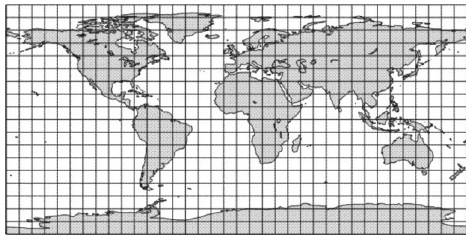
Fig. 25. Map of the World in Plate Carre projection